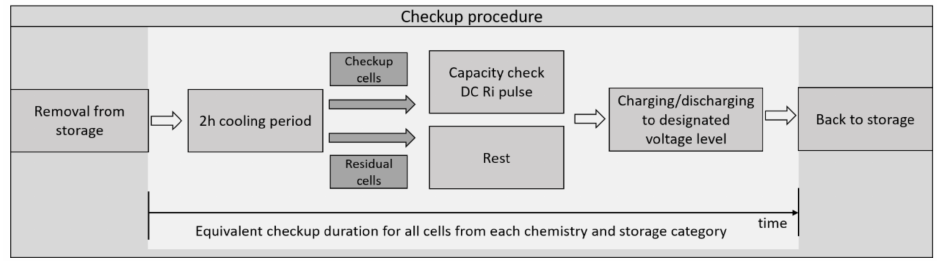
Figure 3. Checkup procedure diagram, the process is repeated for every individual cell group and every condition in a similar extent from Table